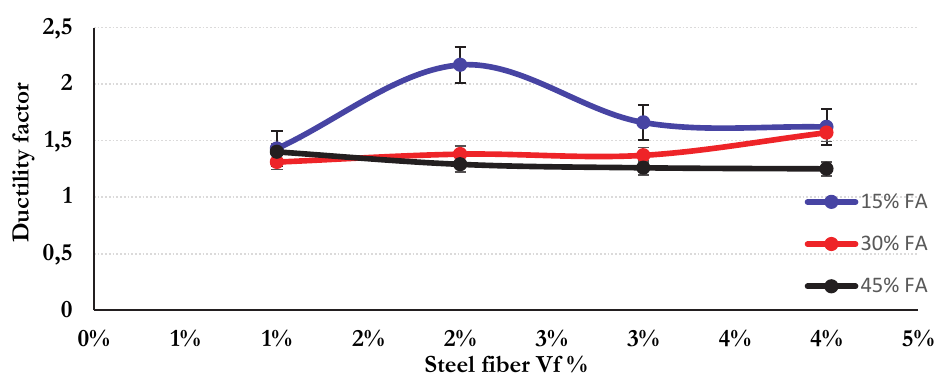
Figure 9: The effect of steel fiber and fly ash volume fraction on the ductility